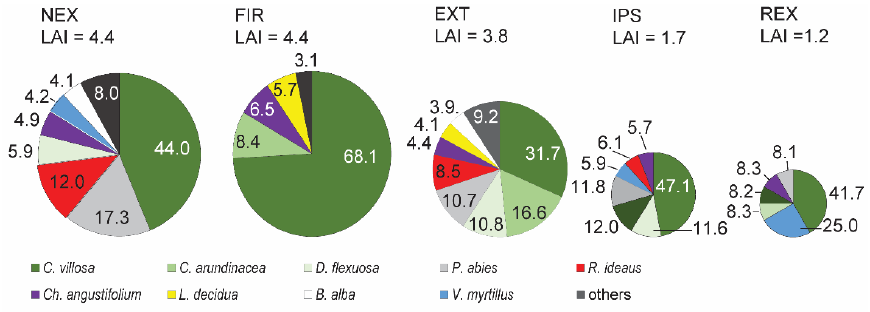
Figure 2. Total leaf area index (LAI) (m 2 m −2 ) and species share [%] for ecosystem types on disturbed sites, where NEX—non-extracted windthrow, FIR—burnt windthrow, EXT—extracted windthrow, IPS—forest killed by bark beetle, REX—one-year-old extracted windthrow.